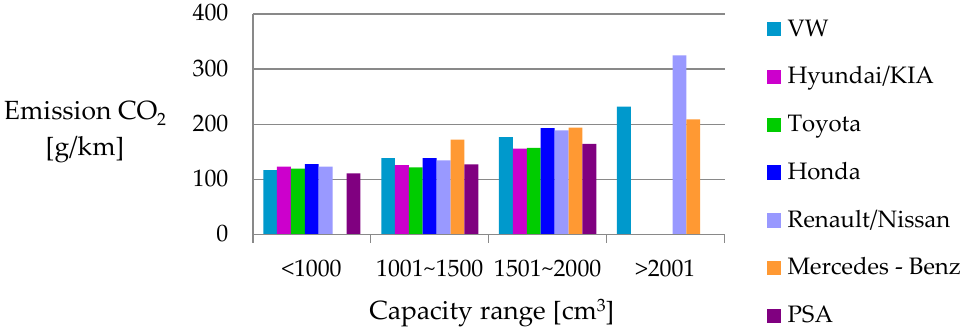
compartments; European and Asian car brands. Source: Developed own.